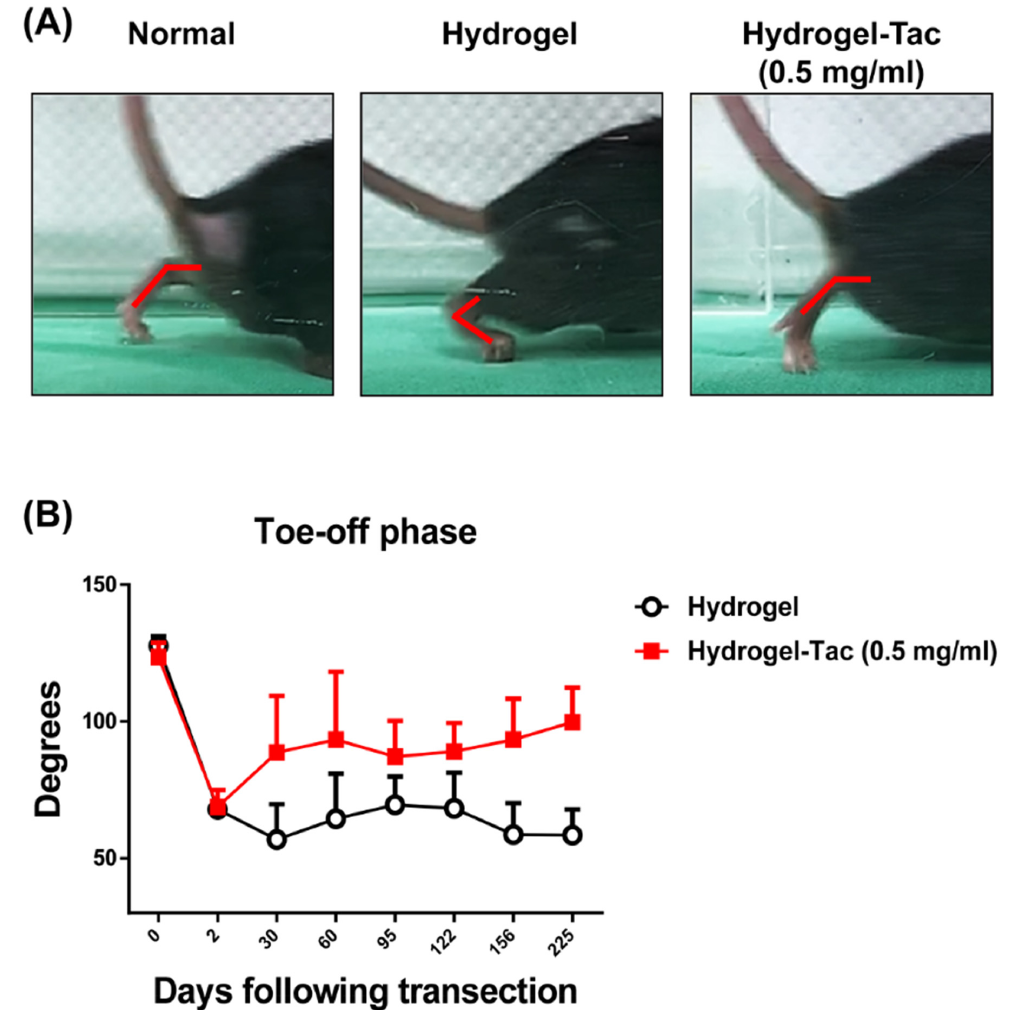
Figure 5. The efficacy of Hydrogel-Tac on sciatic nerve recovery, assessed using video gait analysis. ( A ) Representative photographs of the gait angles on POD 122 in the different groups. Normal control means that the sciatic nerve was not transected, indicating that the gait angle of the feet in the toe-off phase showed a large angle. In the hydrogel and Hydrogel-Tac groups, the sciatic nerves of the right hindlimb were cut and then anastomosed with 10/0 sutures. Subsequently, 0.1 mL of hydrogel or encapsulated-tacrolimus hydrogel (0.5 mg/mL) was injected into the subcutaneous space of the right hindlimb. ( B ) The analysis of the gait angles in the hydrogel and Hydrogel-Tac groups following sciatic nerve transection up to POD 225. The cumulative graph expresses the gait angle of the toe-off phase postoperatively. POD 0 indicates the gait angle measured when the sciatic nerve had not yet been transected. Both groups contained six mice. Mean ± SD was used to represent the statistical data. The comparison of the hydrogel group with the Hydrogel-Tac (0.5 mg/mL) group showed a significant difference on POD 30, 95, 122, 156, and 225 (POD 30 p = 0.0095, POD 95 p = 0.027, POD 122 p = 0.0121, POD 156 p = 0.0011, and POD 225 p < 0.0001, unpaired t -test). The average angle of the normal mouse group was 125.6 ± 1.392.